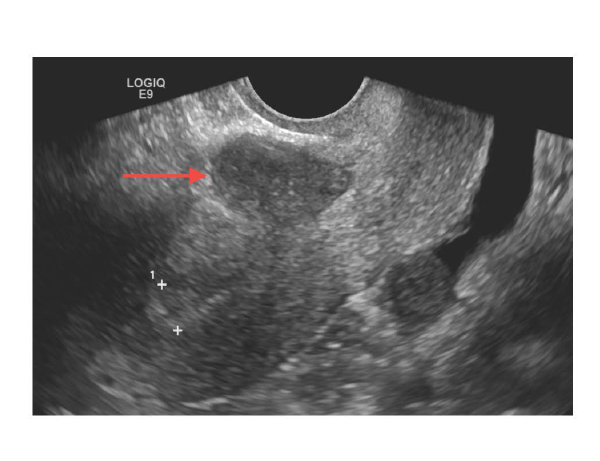
Figure 1. Pelvic Ultrasound Demonstrating Tuberculoma in a Uter- ine